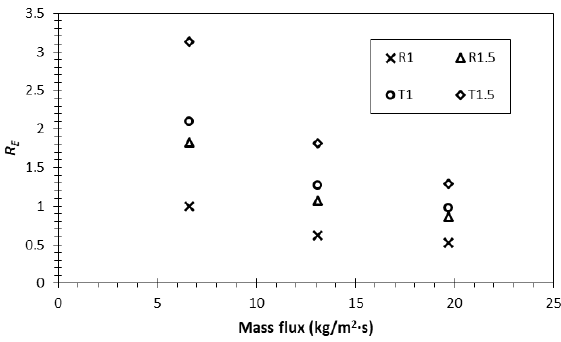
Figure 9. Enhancement ratio among four different surfaces.